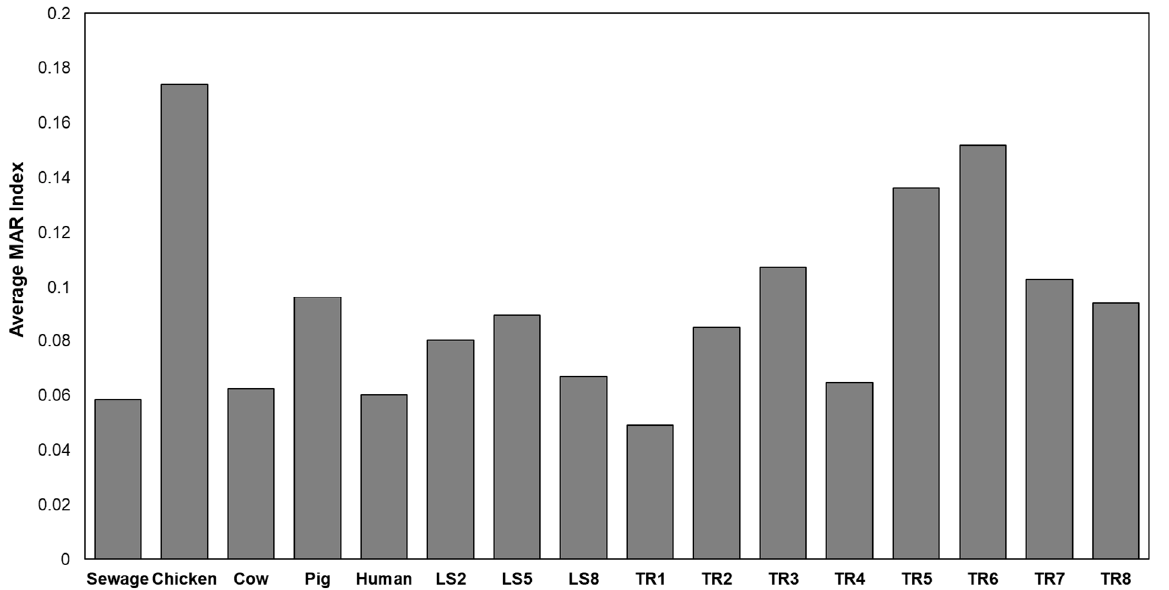
Figure 3. Average MAR indices of sewage, fecal, lake and tributary river samples. LS2, East Bay; LS5, West Bay; LS8, South Bay; TR1, Bagumbayan; TR2, Mangangate; TR3, Sapang Baho; TR4, Tunasan; TR5, Biñan; TR6, Pila; TR7, San Cristobal; TR8, Sta. Rosa; AMP, ampicillin; SXT, trimethoprim– sulfamethoxazole; SAM, ampicillin–sulbactam; CFZ, cefazolin; CIP, ciprofloxacin; GEN, gentamicin.